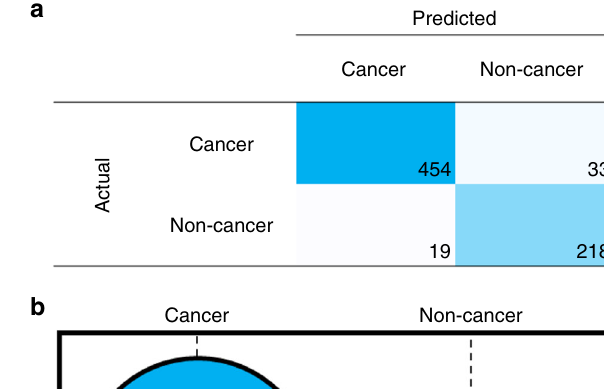
Table 2 Retrospective patient cohort information